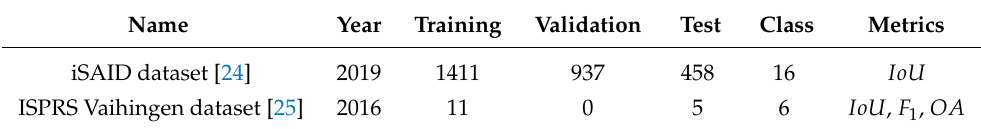
Table 1. The specification of the VHR remote sensing images datasets.